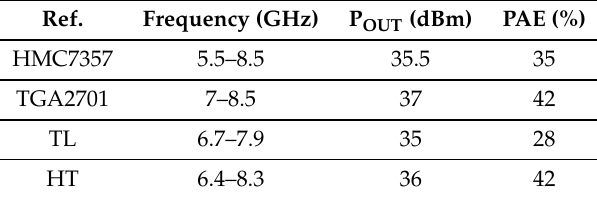
Table 1. Comparison between the designed 7 GHz GaN PAs and commercial GaAs examples.